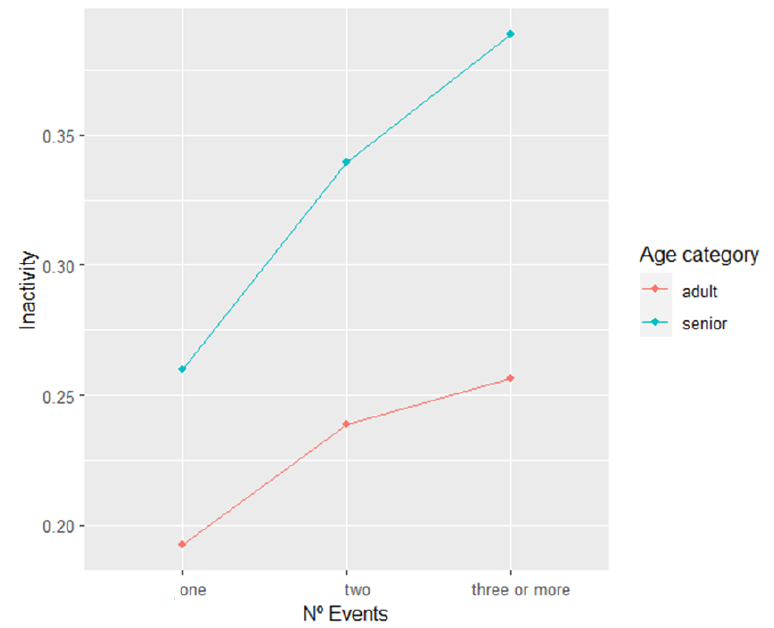
Figure 3. Plots representing the effect of the interaction between age category and N ◦ events on daytime inactivity of the chimpanzees. Each point on the plot is a predicted mean inactivity value and each connection between two points describes the effect, based on the data of the Inactivity LMM model with N ◦ events, max duration, sex, age category, and the interaction of age category and N ◦ events as fixed factors.